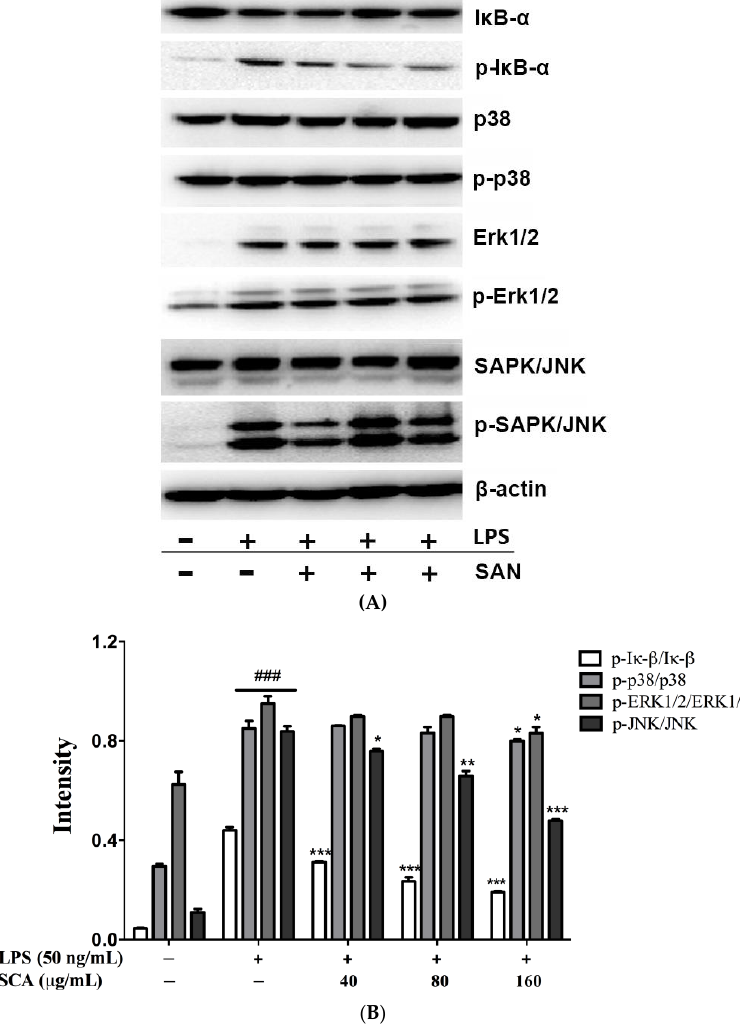
Figure 6. Effect of SCA on IκBα, p38, extracellular signal-regulated kinase (ERK)1/2 and c-Jun N-terminal kinase (JNK)phosphorylation. ( A ) RAW 264.7 macrophages were treated with SCA (40, 80 and 160 μg/mL) for 1 h and then stimulated with LPS (50 ng/mL) for 24 h. IκBα, p38, ERK1/2 and JNK, alone with their phosphorylated products, were analyzed by Western blotting. β -actin was used as the internal control for the lysate and cytosolic fraction. p-IκBα, p-p38, p-ERK1/2 and p-JNK were normalized with IκBα, p38, ERK1/2 and JNK, respectively; ( B ) The bar chart shows the quantitative evaluation of protein bands by densitometry * p < 0.05, ** p < 0.01 and *** p < 0.001 versus LPS-only treatment group; ### p < 0.001 versus control group.